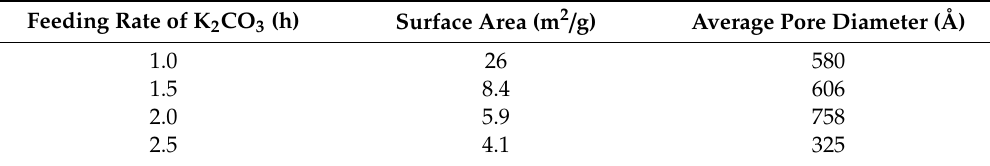
Table 3. BET surface area and average pore diameter analyses of CaCO 3 at di ff erent feeding rates of K 2 CO 3 .